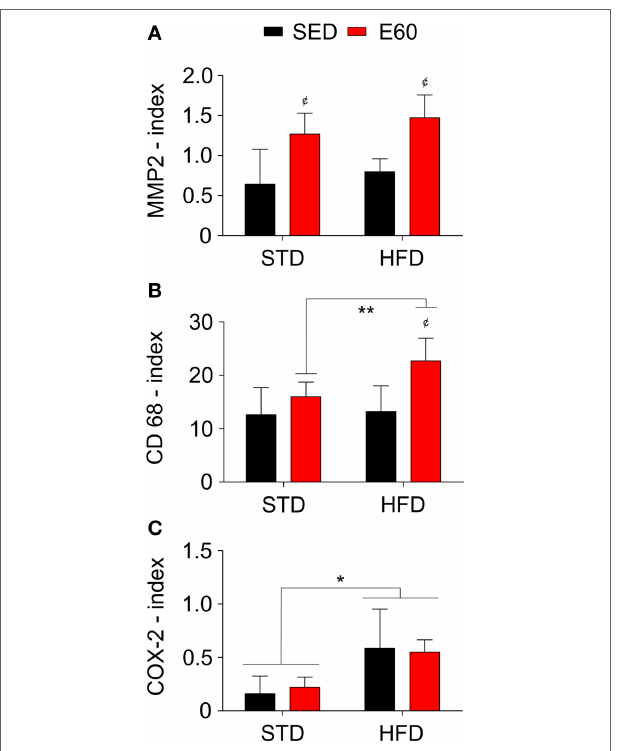
FigUre 2 | a high-fat diet (hFD) promotes inflammation in the aortic tissue . Antibodies against matrix metalloproteinase 2 [MMP2; (a) ], the cluster of differentiation 68 [CD68; (B) ], and cyclooxygenase 2 [COX-2; (c) ] stained aortic samples for histopathological analysis. The index was determined to be the number of positive cells per area (square millimeter). Statistical Analysis I: ¢ p < 0.05 vs. STD-SED or HFD-SED. Statistical